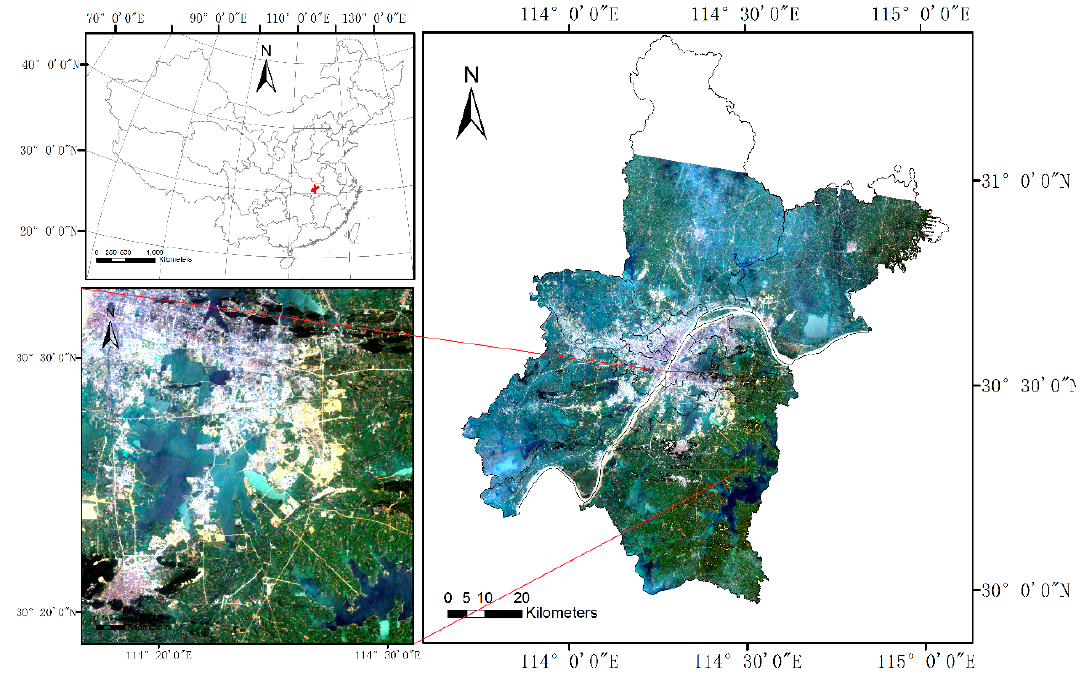
Figure 1. Study site: the upper left panel shows the location of Wuhan in China; the right panel illustrates the city boundary and an example Landsat image acquired on 31 July 2007; and the bottom left panel shows the detail of an image subset. Table 1. Landsat images used in this study.